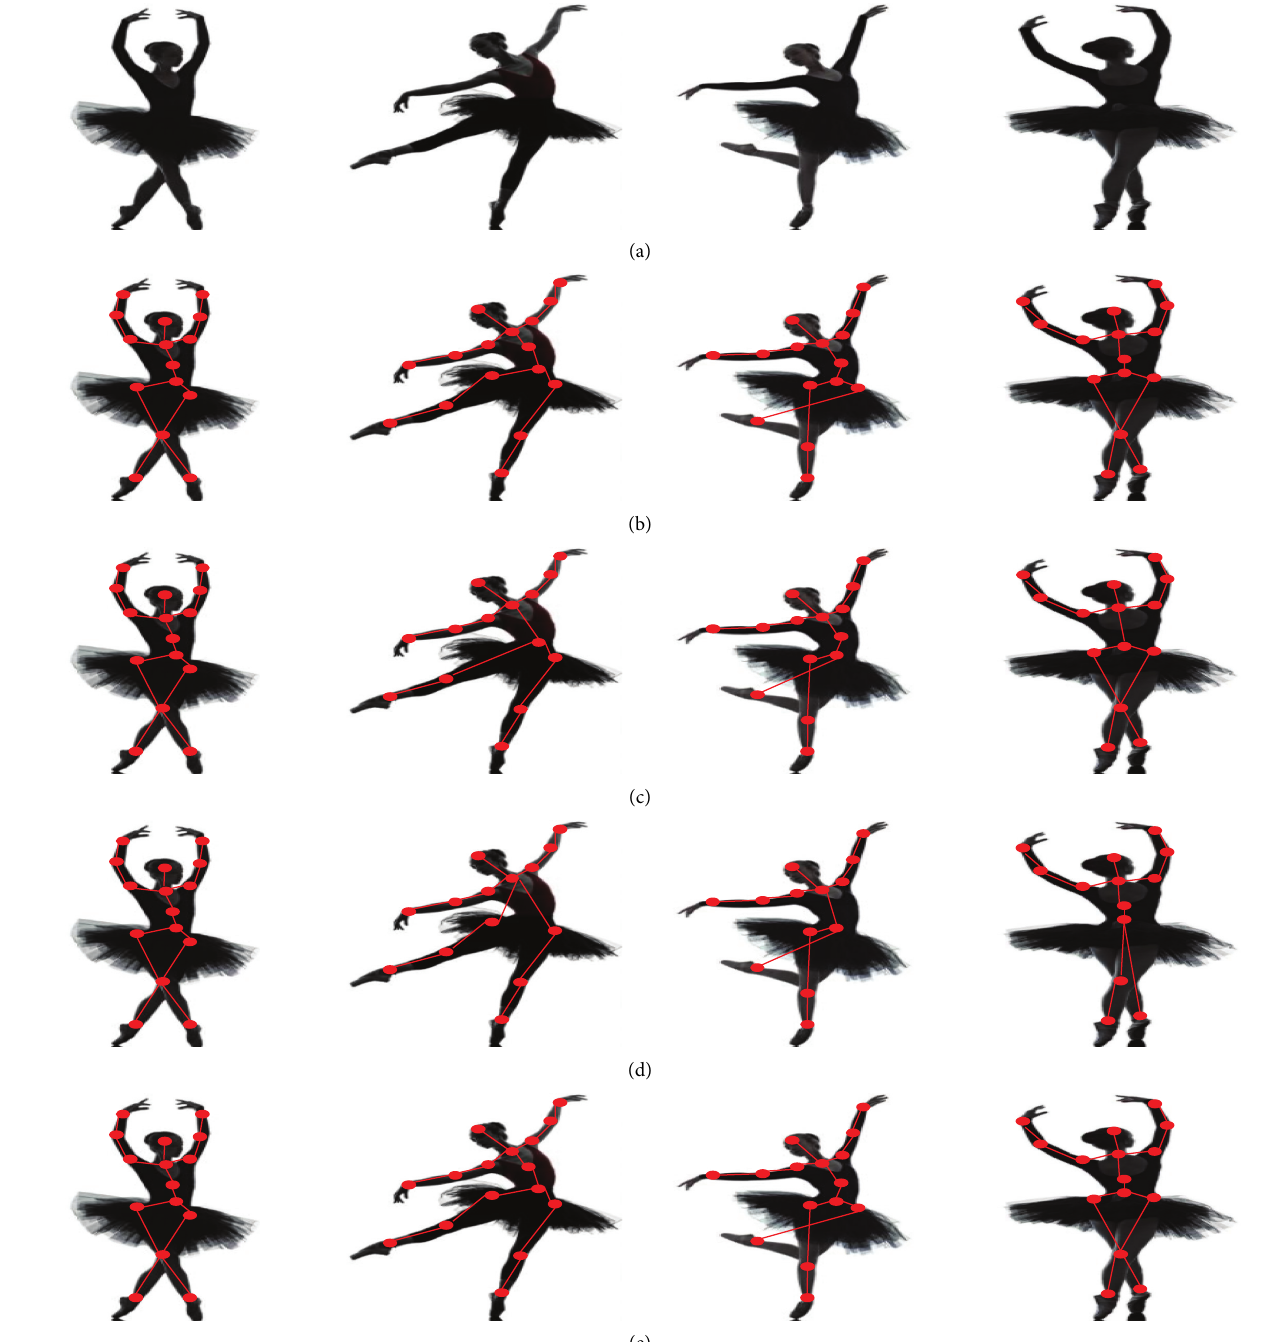
Figure 7: Skeleton key point prediction based on multifeature fusion. (a) Original image; (b) key of real human skeleton; (c) hourglass predictions; (d) FPN prediction; (e) our